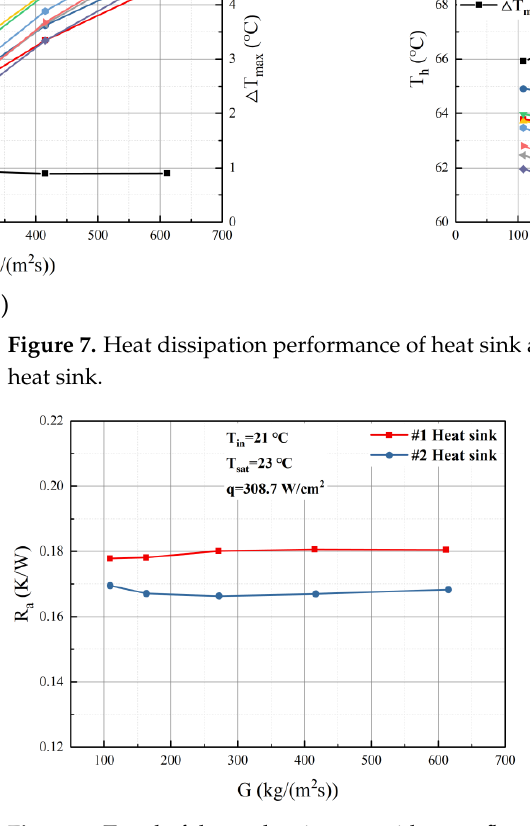
Figure 8. Trend of thermal resistance with mass flux.